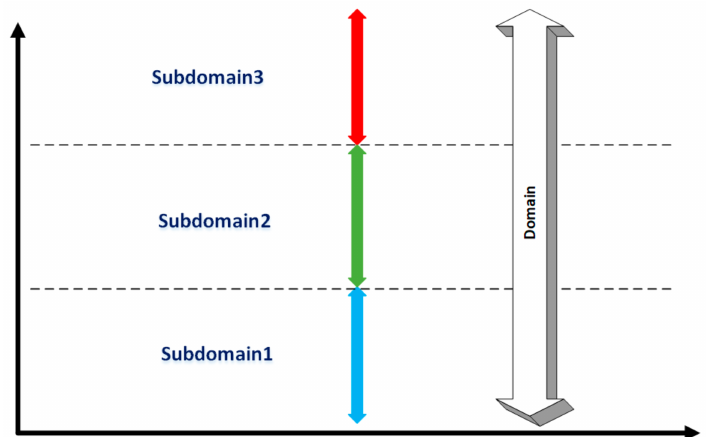
Figure 8. An example domain and its subdomains.